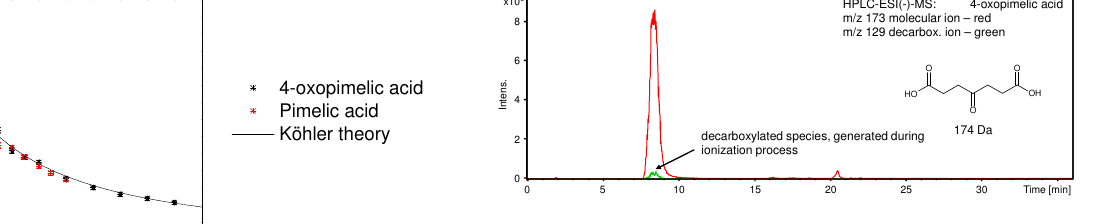
Fig. 15. HPLC-ESI( − )-MS extracted ion chromatograms of 4- oxopimelic acid. The signals from the product of decarboxylation and from the molecular ion are coincident (retention time approx- imately 8.3min), indicating that the decarboxylation occurred dur- ing the ionization